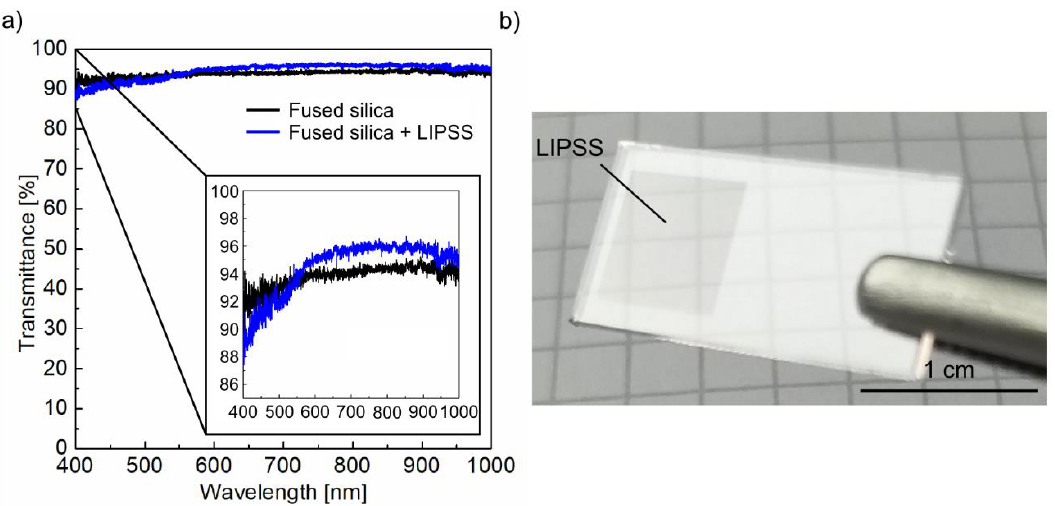
Figure 8. Optical characterization of fused silica samples before and after fs-laser irradiation: ( a ) transmittance measured using an integrating sphere and ( b ) photograph demonstrating the reduced reflectivity of the surface area homogenously structured with HSFL.